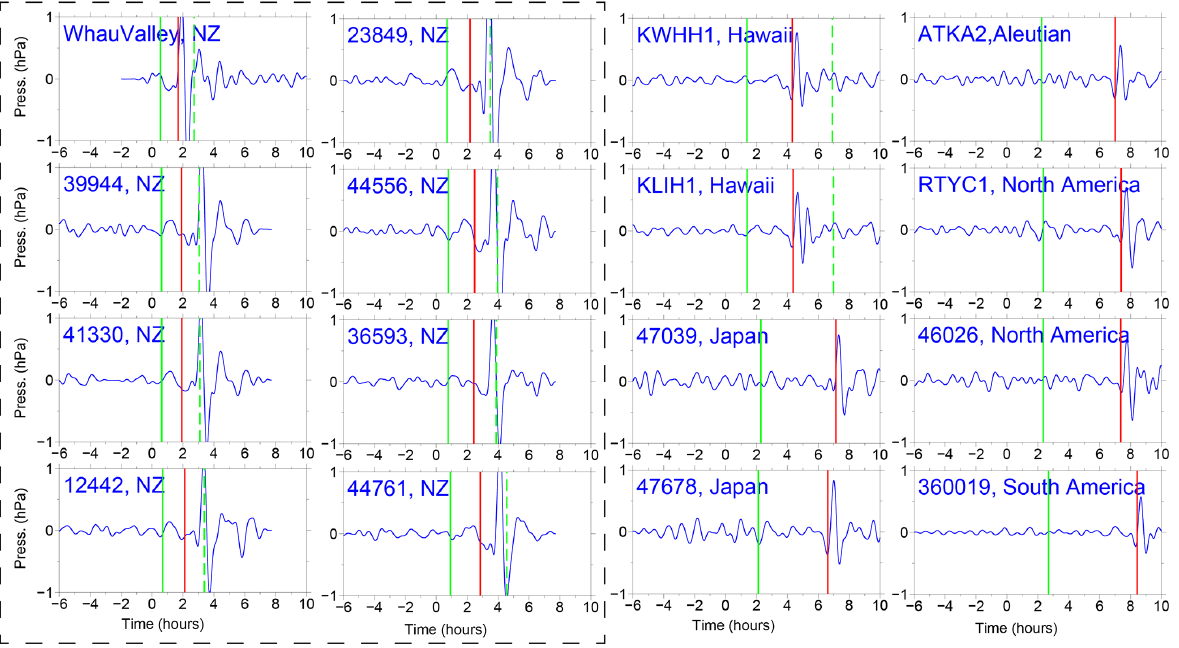
Figure 7. Shock-wave-related atmospheric pressure waveforms of selected barometers in the Pacific Ocean. All traces have been filtered between 30 and 150min. In each subplot, the solid vertical green lines mark the arrival time with a travelling velocity of 1000ms − 1 . The solid vertical red lines mark the arrivals of Lamb waves. The dashed vertical green lines mark the lower limit of AGWs’ velocity of 200ms − 1 .